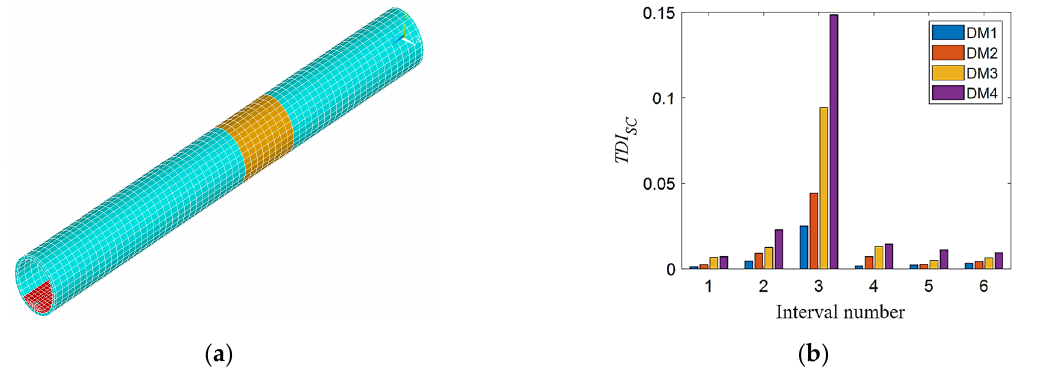
Figure 8. TDI SC index verification for different degrees of single additional mass damage: ( a ) single additional mass damage tunnel model in the third interval and ( b ) TDI SC at different degrees of single additional mass damage.